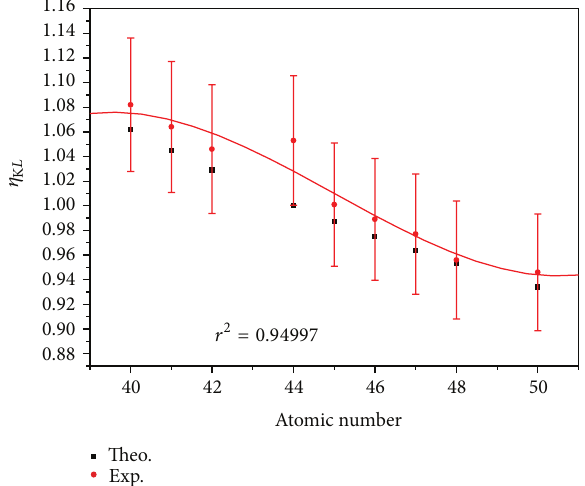
as a function of atomic number. K